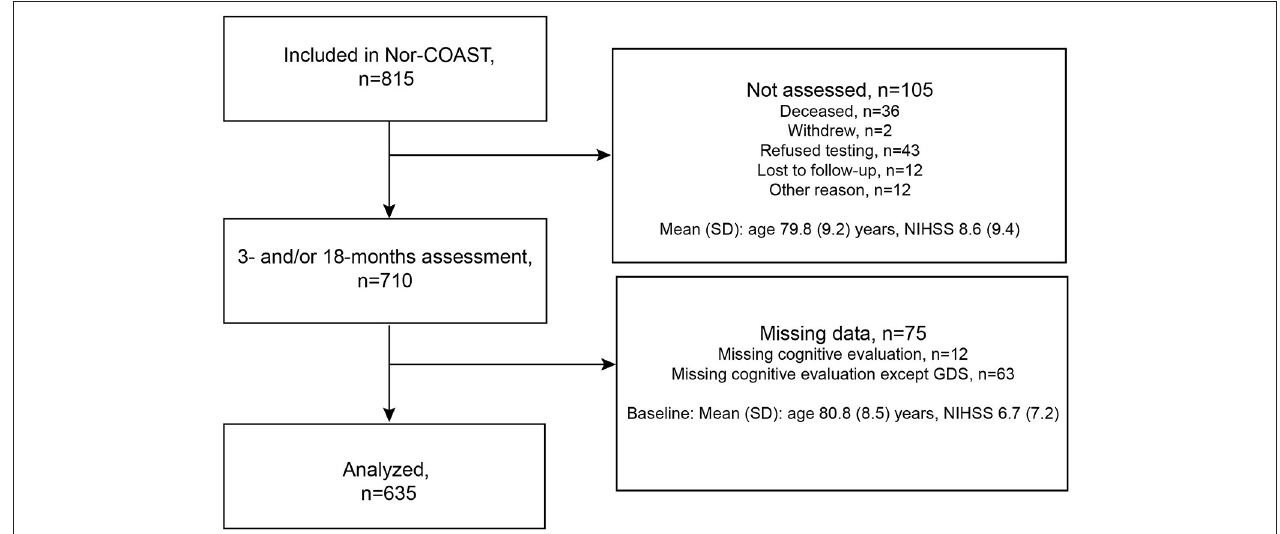
FIGURE 1 | Flowchart of patients included in the study.